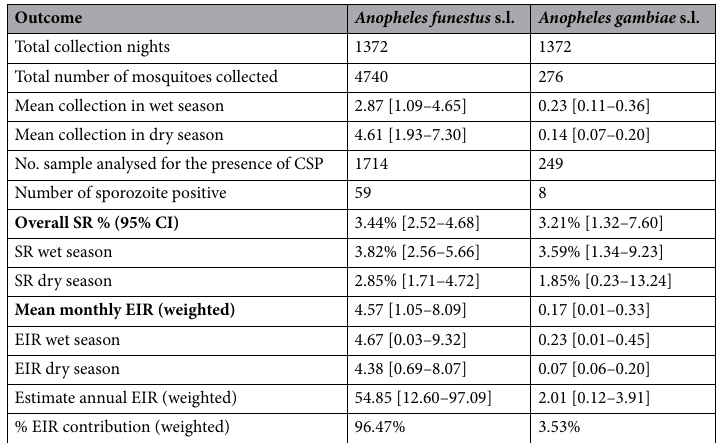
Table 3. Seasonal variation between An. funestus s.l. and An. gambiae s.l. sporozoite rate and entomological inoculation rate (EIR). CSP circumsporozoite protein, EIR entomological inoculation rate, SR sporozoite